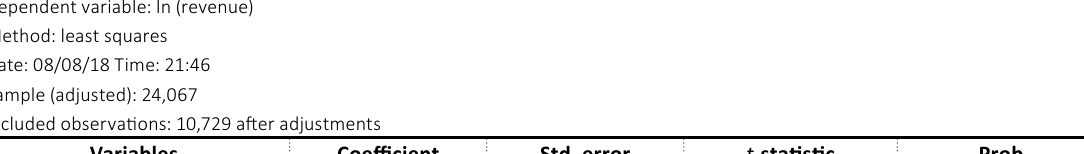
Table A6. Estimation result of model (2) with D